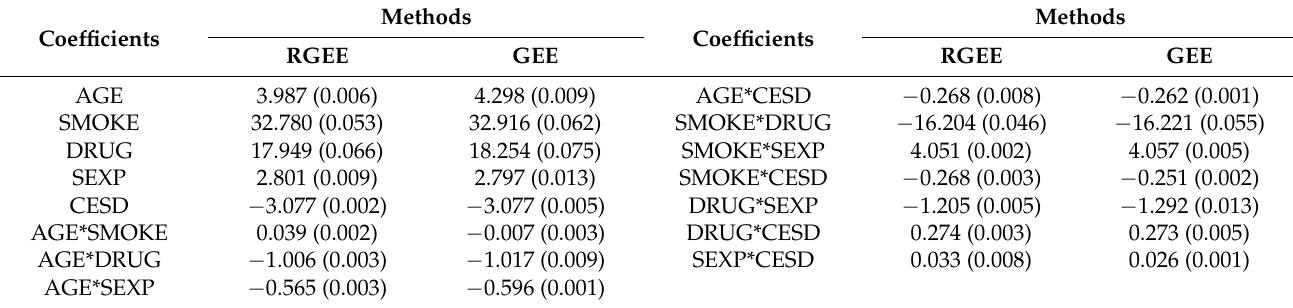
Table 2. Regression coefficient estimates (SD) in the analysis of the CD4